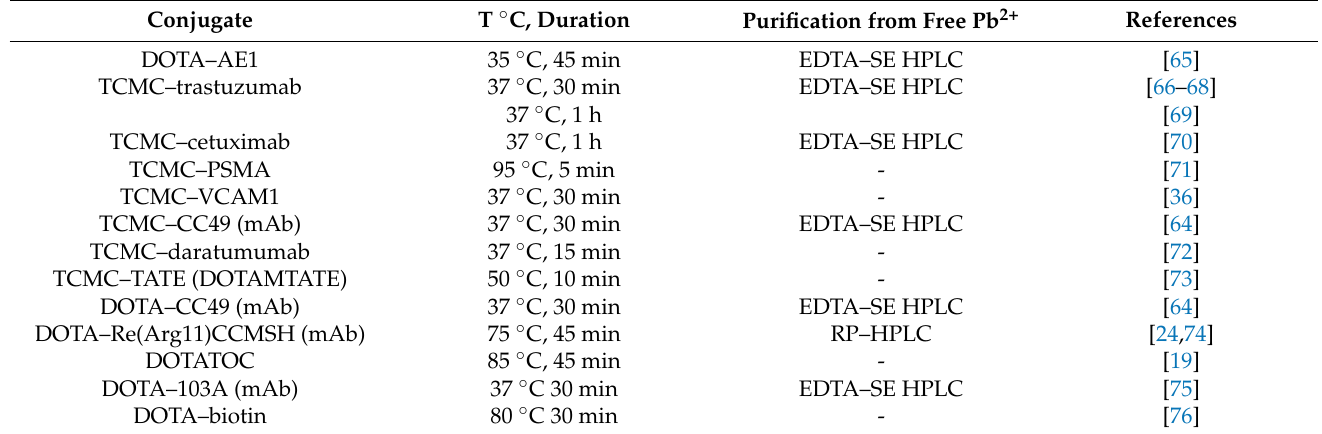
Table 3. Radiolabeling of monoclonal antibodies, peptides, and other molecules with 203,212 Pb. Conjugate T ◦ C,